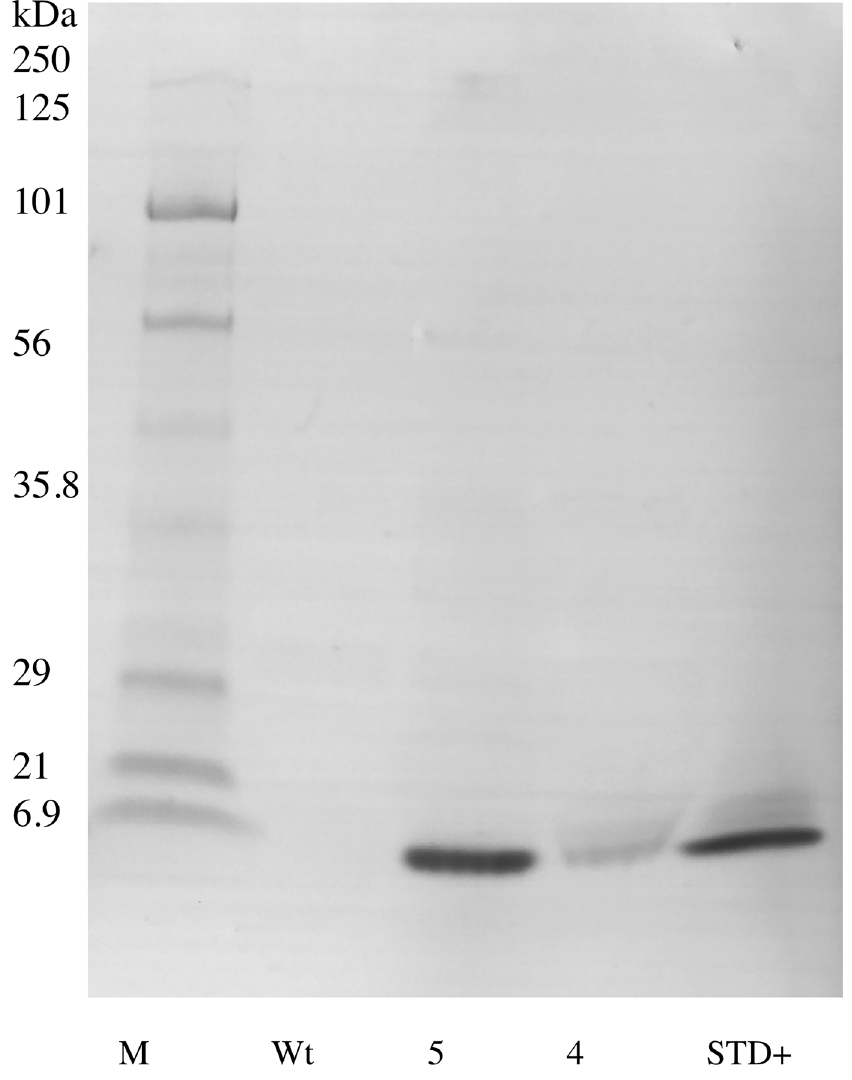
Fig 3. Immunoblot of enriched small molecular weight soluble protein extracted from dry transgenic ShEGF soybean seeds. Protein extracts from two independent homozygous lines (5 and 4) are compared to both nontransgenic (Wt) and commercially available EGF standard (STD +). EGF was detected using an EGF specific antibody and indirect secondary antibody coupled to alkaline phosphatase. M marker; kDa